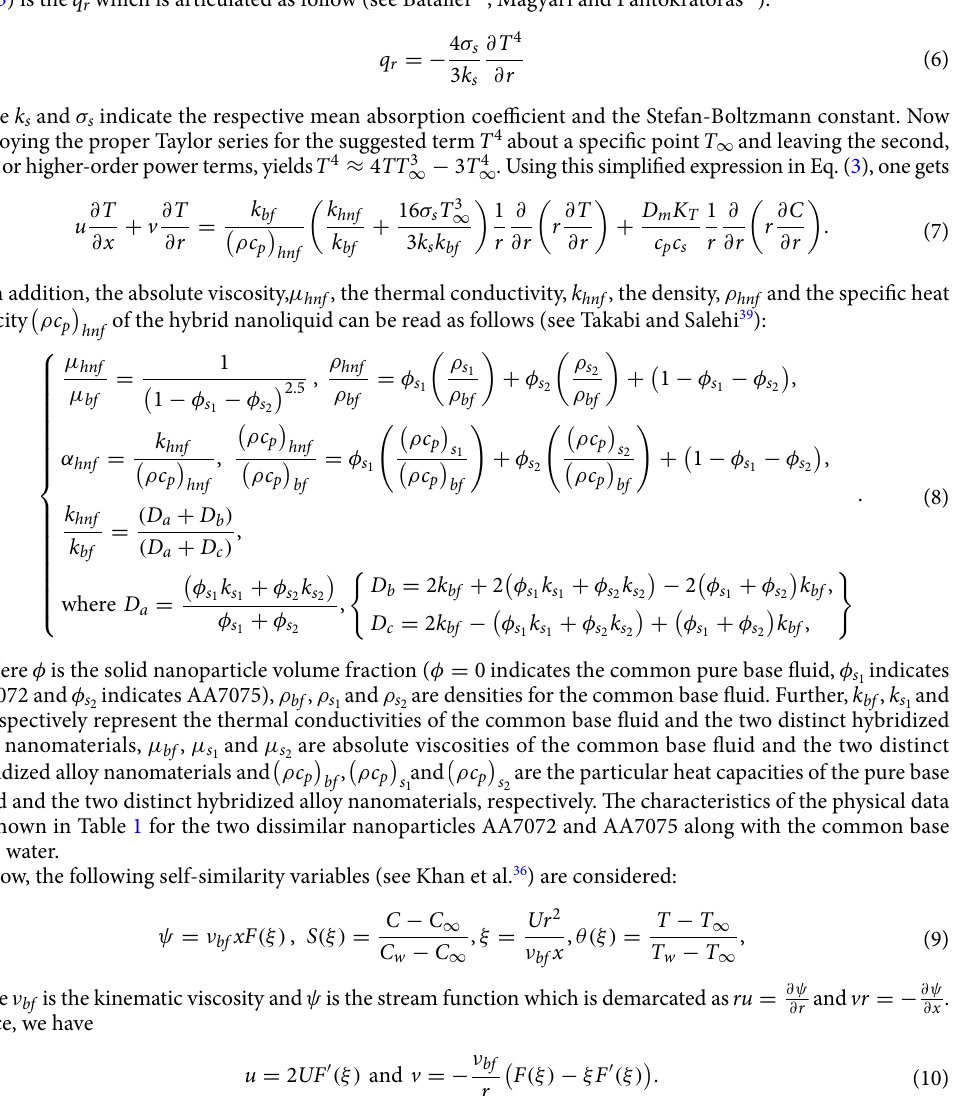
where v and u are the given velocity relative components measured in the respective r centration and T the temperature. Moreover, D B corresponds the Brownian diffusion coefficient, D m is the mass diffusivity coefficient, c p is the heat capacity at uniform pressure, c s is the nanoparticle concentration susceptibility, K T is the ratio of thermal diffusion and T m is the fluid mean temperature. The rest of the mathematical symbols used for the hybrid nanofluid will be defined later in the same section. The well-established Rosseland approximation which is applicable and describe the radiative heat transfer q r in the limit of an optically thick fluid (hybrid nanofluid) is employed. The related term involves in the aforesaid Eq. (3) is the q r which is articulated as follow (see Bataller 40 ; Magyari and Pantokratoras 41 ):